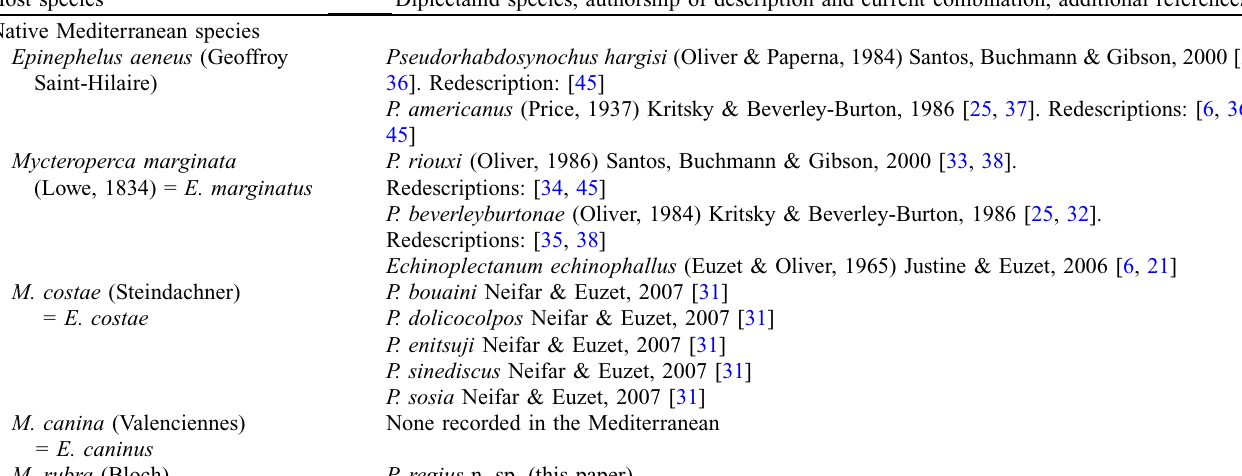
Table 1. Groupers in the Mediterranean (according to [7, 8]) and their diplectanid species. The placement of certain host species in Mycteroperca follows recent molecular results [4, 40]; some of these species were previously classified within Epinephelus. Diplectanid species, authorship of description and current combination, additional